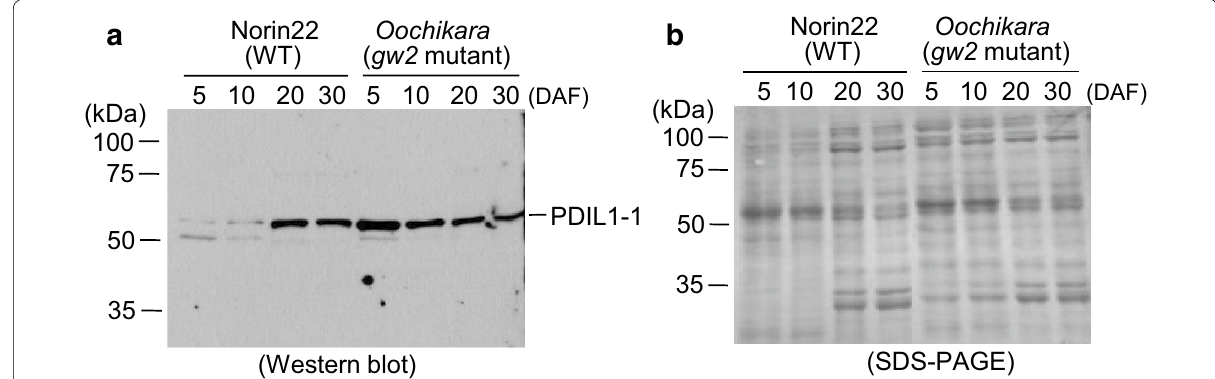
Fig. 4 Accumulation of PDIL1-1 protein in gw2 mutant (Oochikara) and wild-type (Norin 22) seeds during development. Total proteins were extracted from Norin 22 and Oochikara seeds at the indicated time points. After SDS-PAGE, proteins were transferred onto a nitrocellulose membrane. a Immunodetection of PDIL1-1 protein using anti-PDIL1-1 antibody. b SDS–polyacrylamide gel stained with Coomassie brilliant blue after blotting. PDIL1-1, protein disulfide isomerase-like 1-1